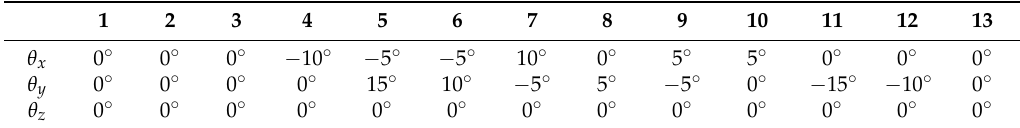
Table 3. The rotation angles of Model 2 in Scene